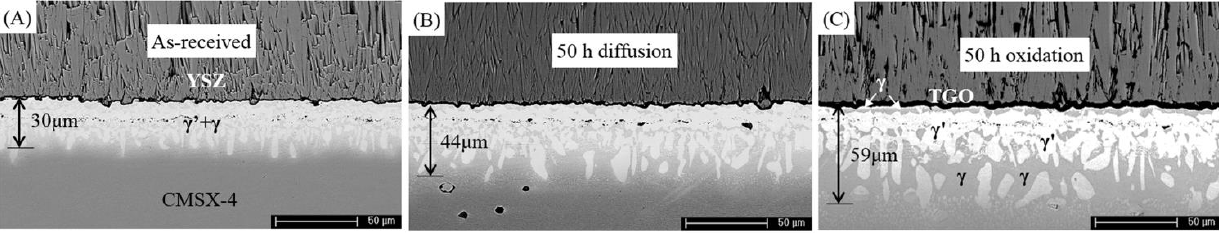
Figure 2. Cross-sectional BSE images of standard Pt-diffused γ’ + γ bond coat: ( A ) as-received; ( B ) 50 h diffusion in vacuum at 1150 °C; ( C ) 50 h oxidation in air at 1150 °C.